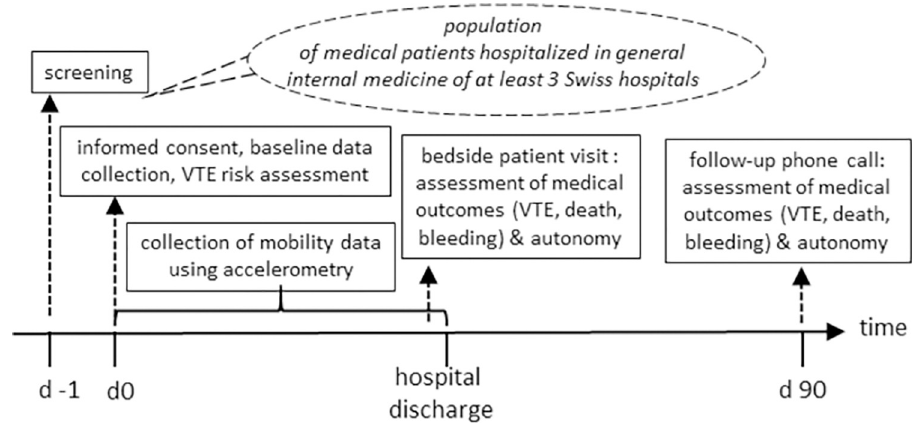
Fig 2. Study organization and